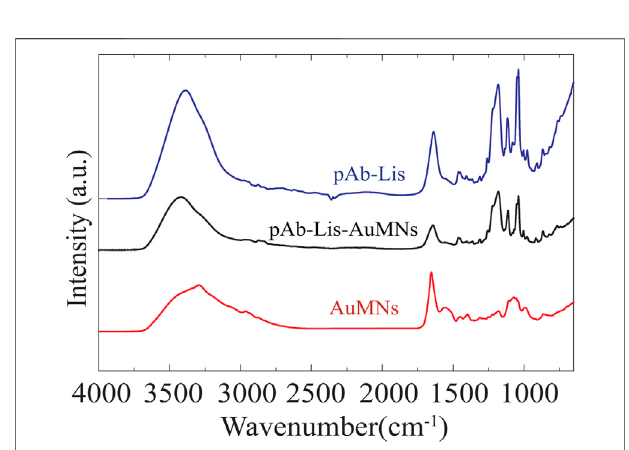
FIGURE 4 | Normalized FT-IR curve showing peak matching between the as-received AuMNs, the pAb-Lis and the pAb-Lis-AuMNs. Note that a full table of peak assignments is shown in Supplementary Table S1 .